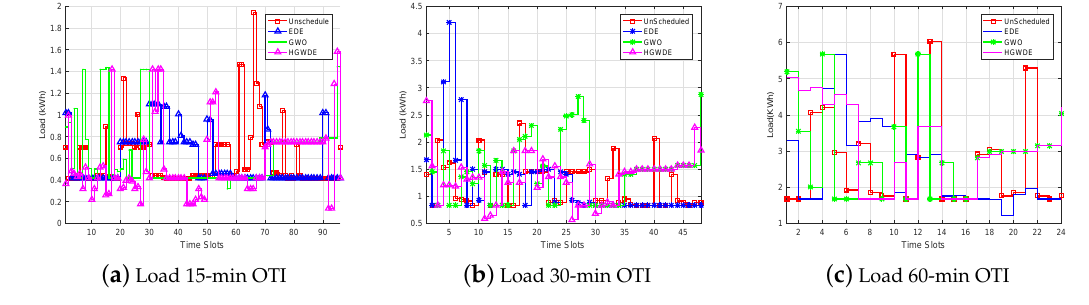
Figure 6. Load per time slot for RTP.